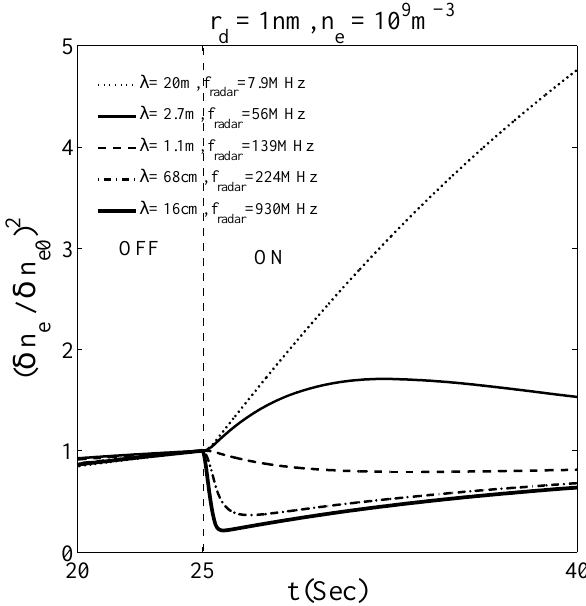
Fig. 1. The time evolution of electron irregularities during radio wave heating for varying irregularity scale size (radar frequency) utilizing the computational model. The heating is turned on at 25s. parameters. The PMSE enhancement after the pump turn-on The heating is turned on at 25 seconds. for a set of parameters may change to a suppression in the electron irregularity amplitude because of small variations of these